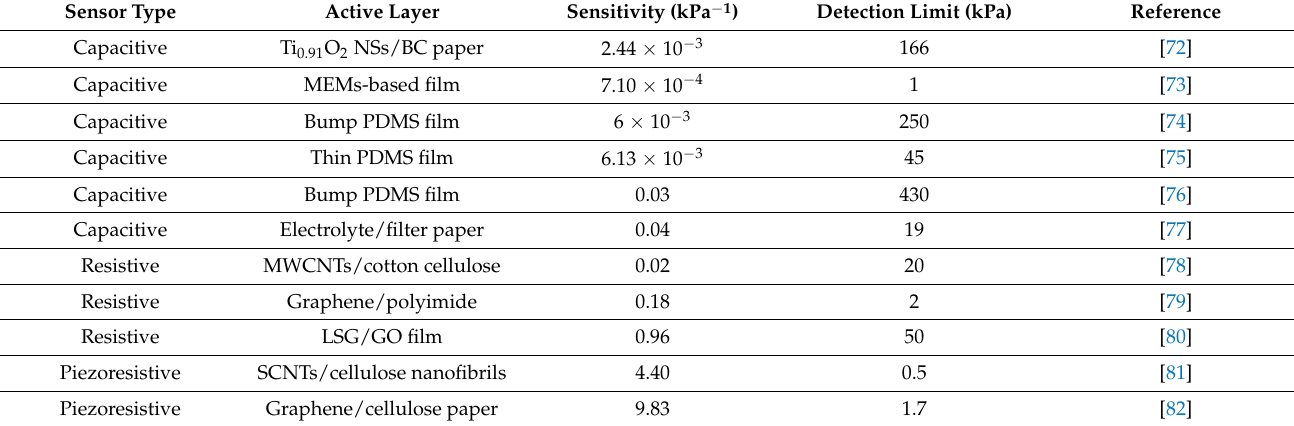
Table 3. Properties of selected flexible pressure sensors with different sensing mechanisms *.